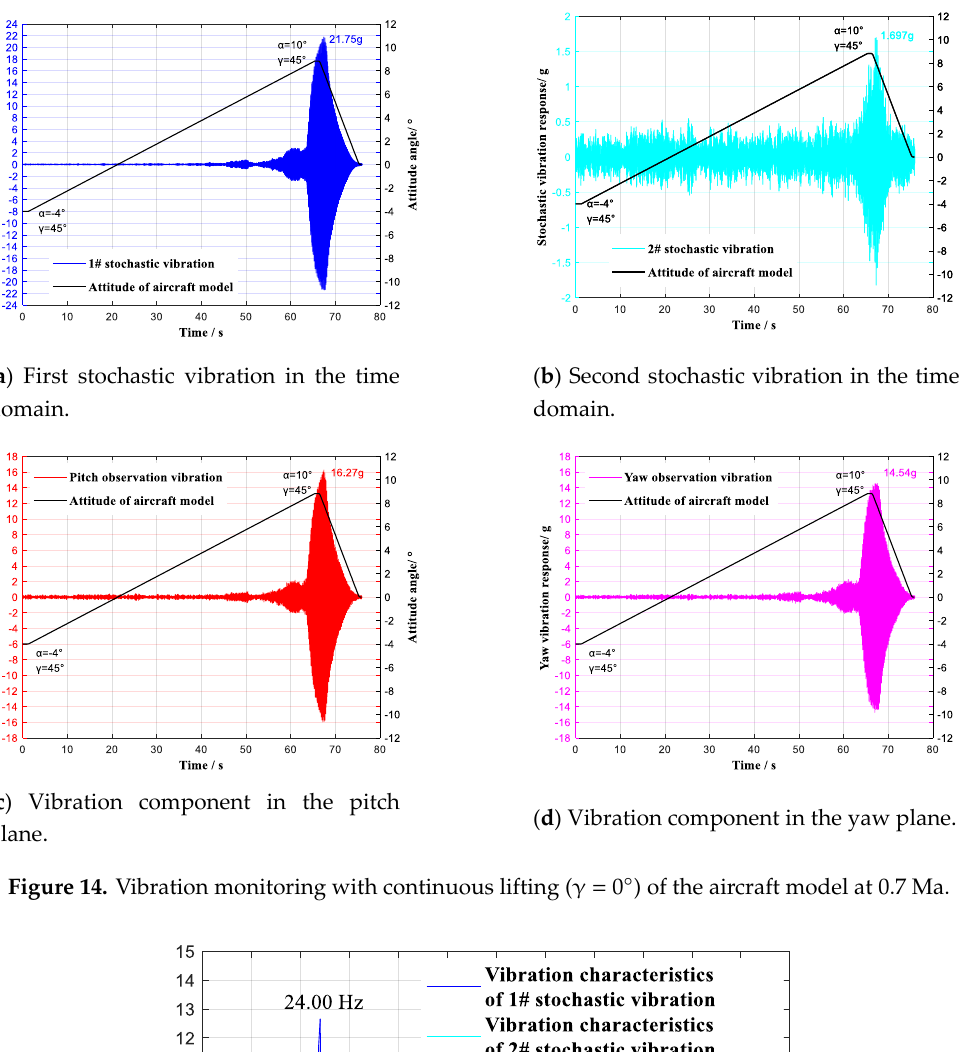
Figure 15. Comparison of vibration characteristics with continuous lifting (γ = 0°) of the aircraft model at Ma = 0.7.